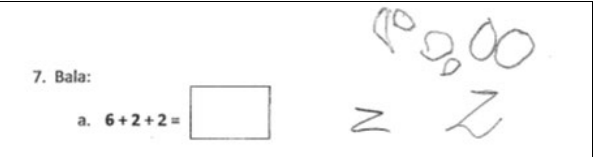
Figure 1: Extract 1 from grade 1 script, learner A